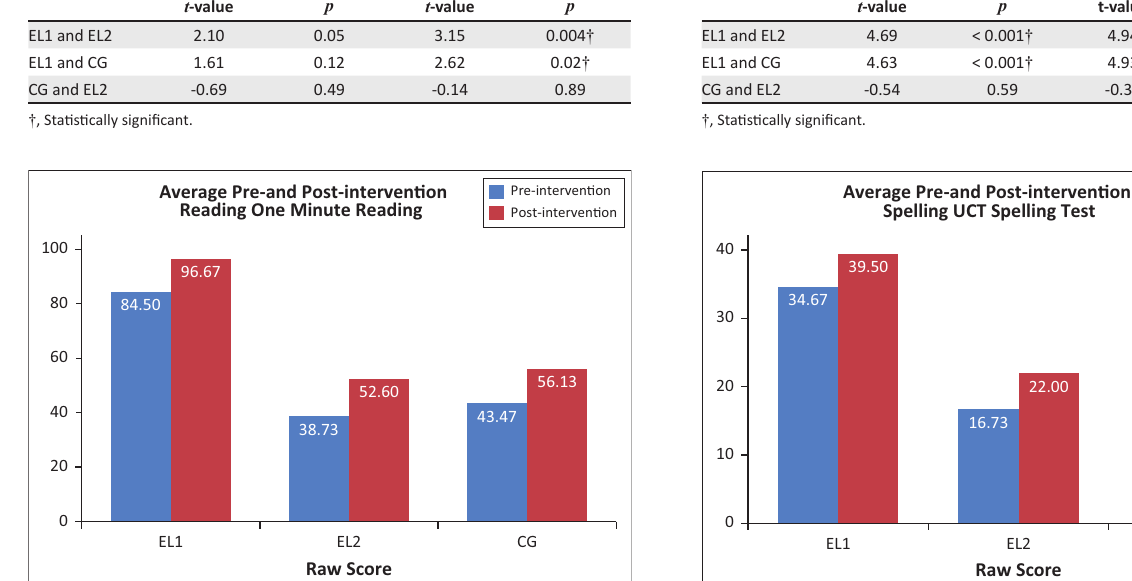
TABLE 6: Results of t -tests for significant differences in phonological blending scores between groups. Groups